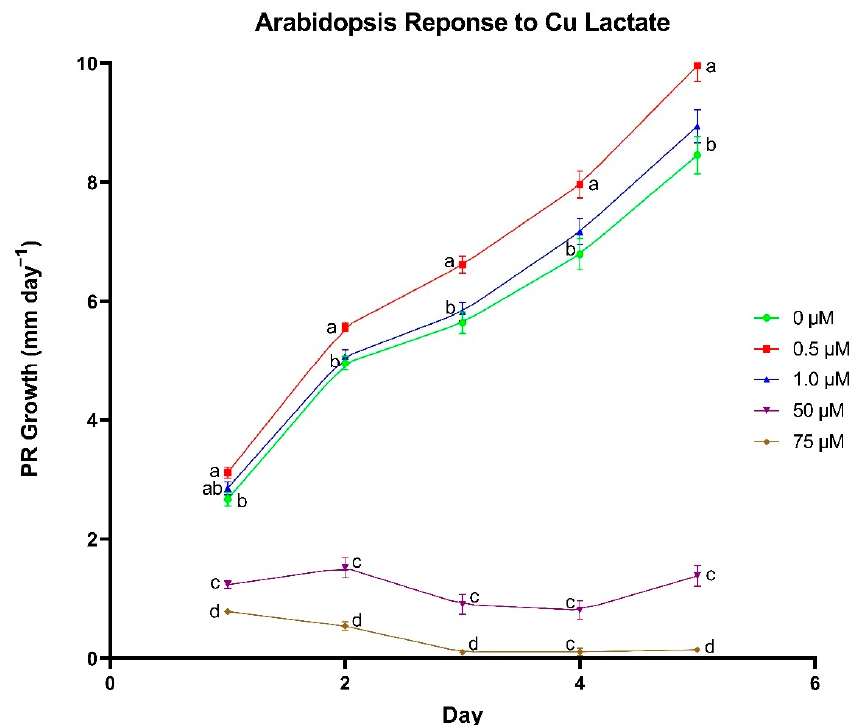
Figure 3. The effect of copper (Cu) lactate concentration on primary root (PR) growth rate in Arabidopsis thaliana . Differences between means were compared using Tukey’s Honest Significant Difference test, where different letters indicate a statistically significant difference between treatment concentrations in their respective day of growth. Error bars denote means ± SE ( n = 60–82).